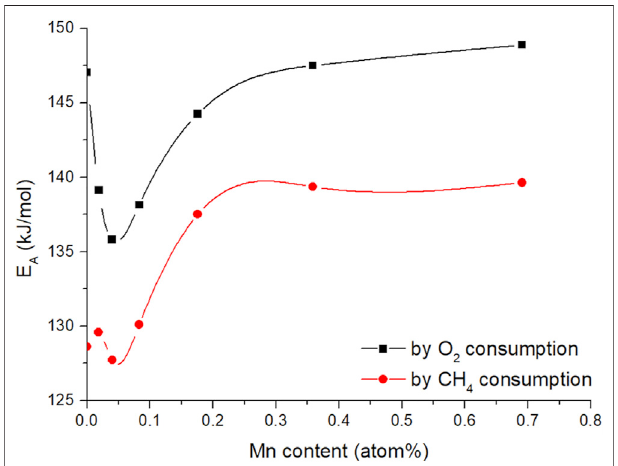
FIGURE 12 | Change of oxygen and methane reaction rates normalized to amount of doping atoms vs total loading (50 mg carbonate